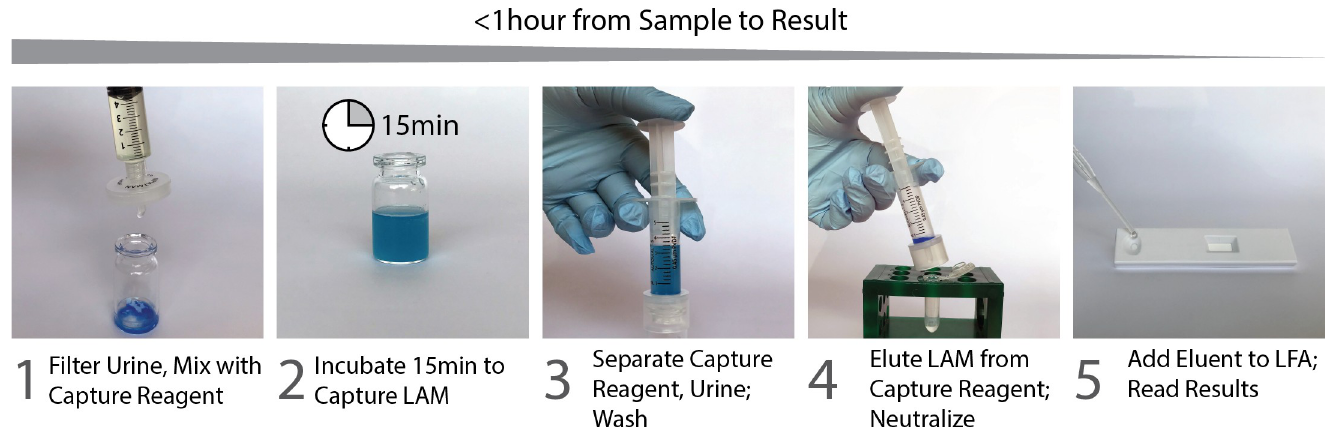
Fig 1. Schematic of the prototype test workflow. (1) Patient urine is passed through a filter to remove any large particulates and mixed with the Concentration Capture Reagent. (2) Urine and Concentration Capture Reagent are allowed to incubate at room temperature for 15min in order to capture any LAM in the sample. (3) The Concentration Capture Reagent is separated from the bulk urine by passing through the filter of an Autovial, discarding the urine, and it is washed with 1mL Wash Buffer, which is also passed through the filter to waste. (4) 300 μ L of Elution Buffer is added to the washed Concentration Capture Reagent and incubated for 5min to release any captured LAM; it is passed through the filter and instantly mixed with 35 μ L of Neutralization Buffer. (5) 150 μ L of this neutralized eluent is added to the LFA and results are read after 30min.